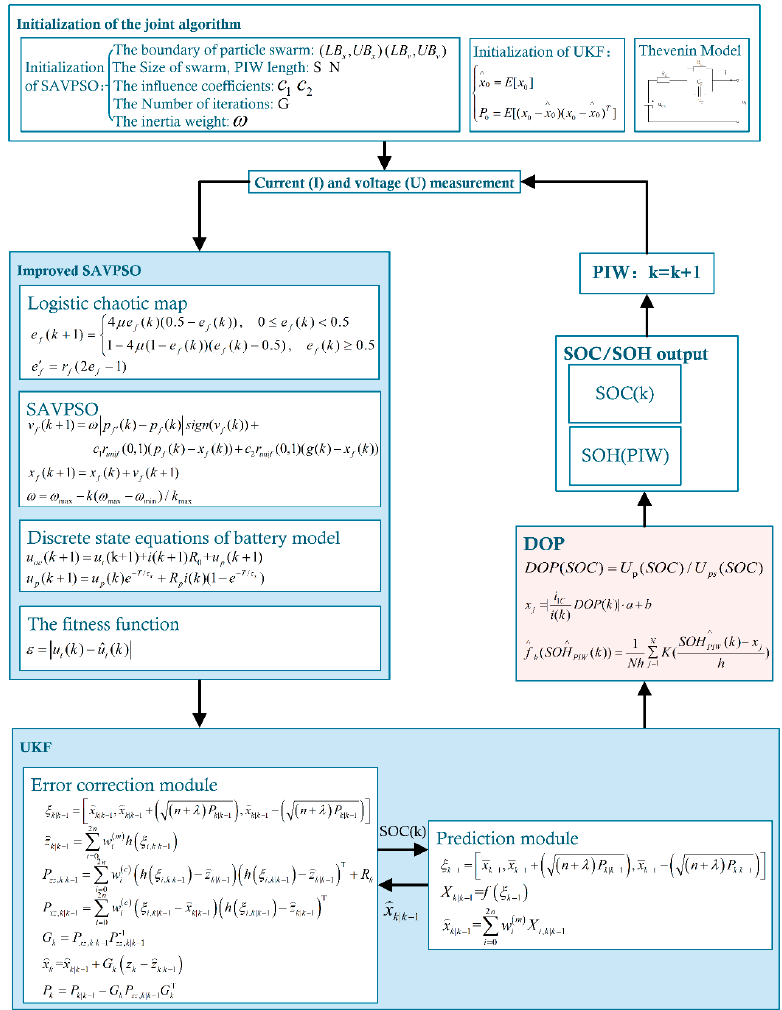
Figure 4. Schematic of the joint algorithm.